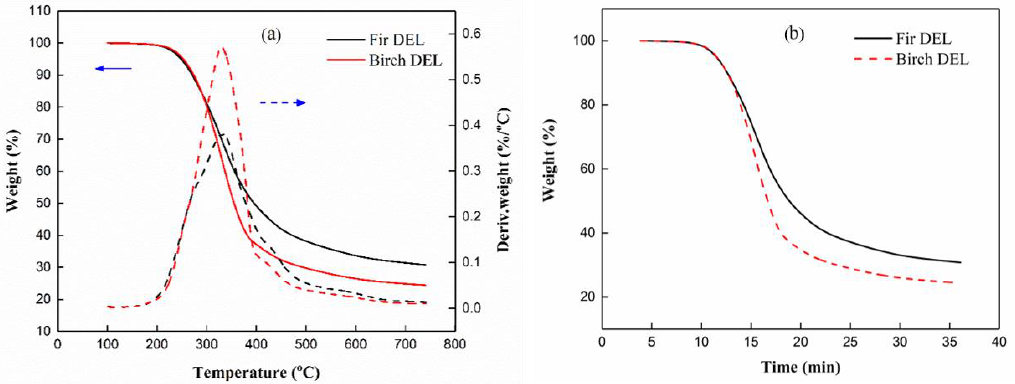
Figure 6. ( a ) Weight losses of Chinese fir DEL and birch DEL at a heating rate of 20 °C/min; ( b ) Weight losses of Chinese fir DEL and birch DEL at 750 °C for 30 min. (The left arrow indicates the Y axis of the curve is on the left side, and the right arrow indicates the Y axis of the curve is on the right side.)